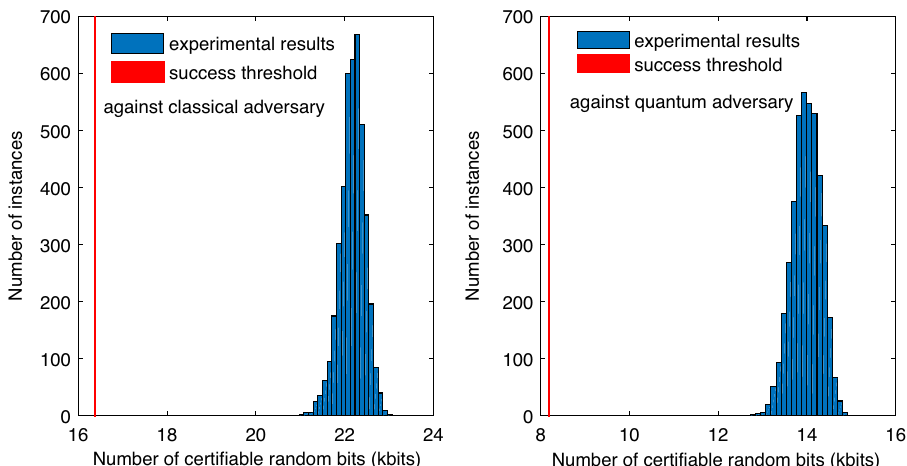
Fig. 4 Histogram of the numbers of random bits certi fi able with soundness error 2 − 64 from 4200 instances of our QRNG: the left and right panels are for certifying randomness with respect to classical and quantum side information, respectively. Each instance of our QRNG uses a data block obtained in 0.1 s runtime. In each panel, the experimental results are shown as blue bars, while the success threshold is shown as the red